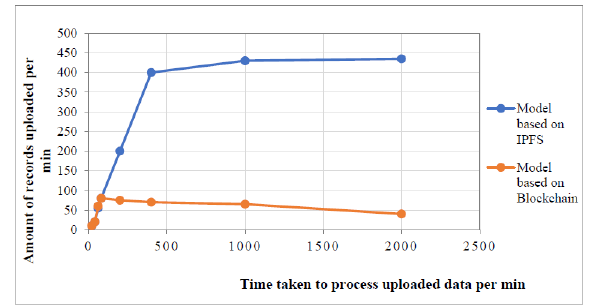
Fig. 5.1. Efficiency of IPFS in comparison with Blockchain